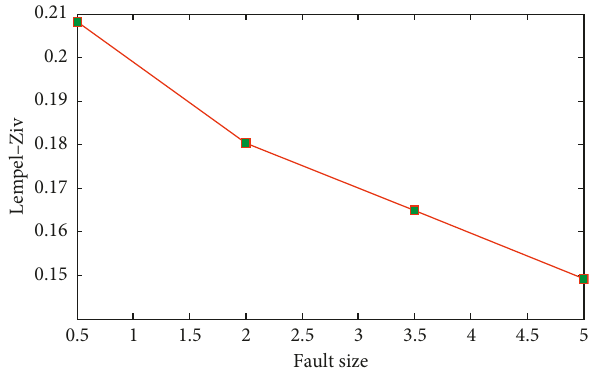
Figure 8: Lempel–Ziv trend graph of inner race defect.